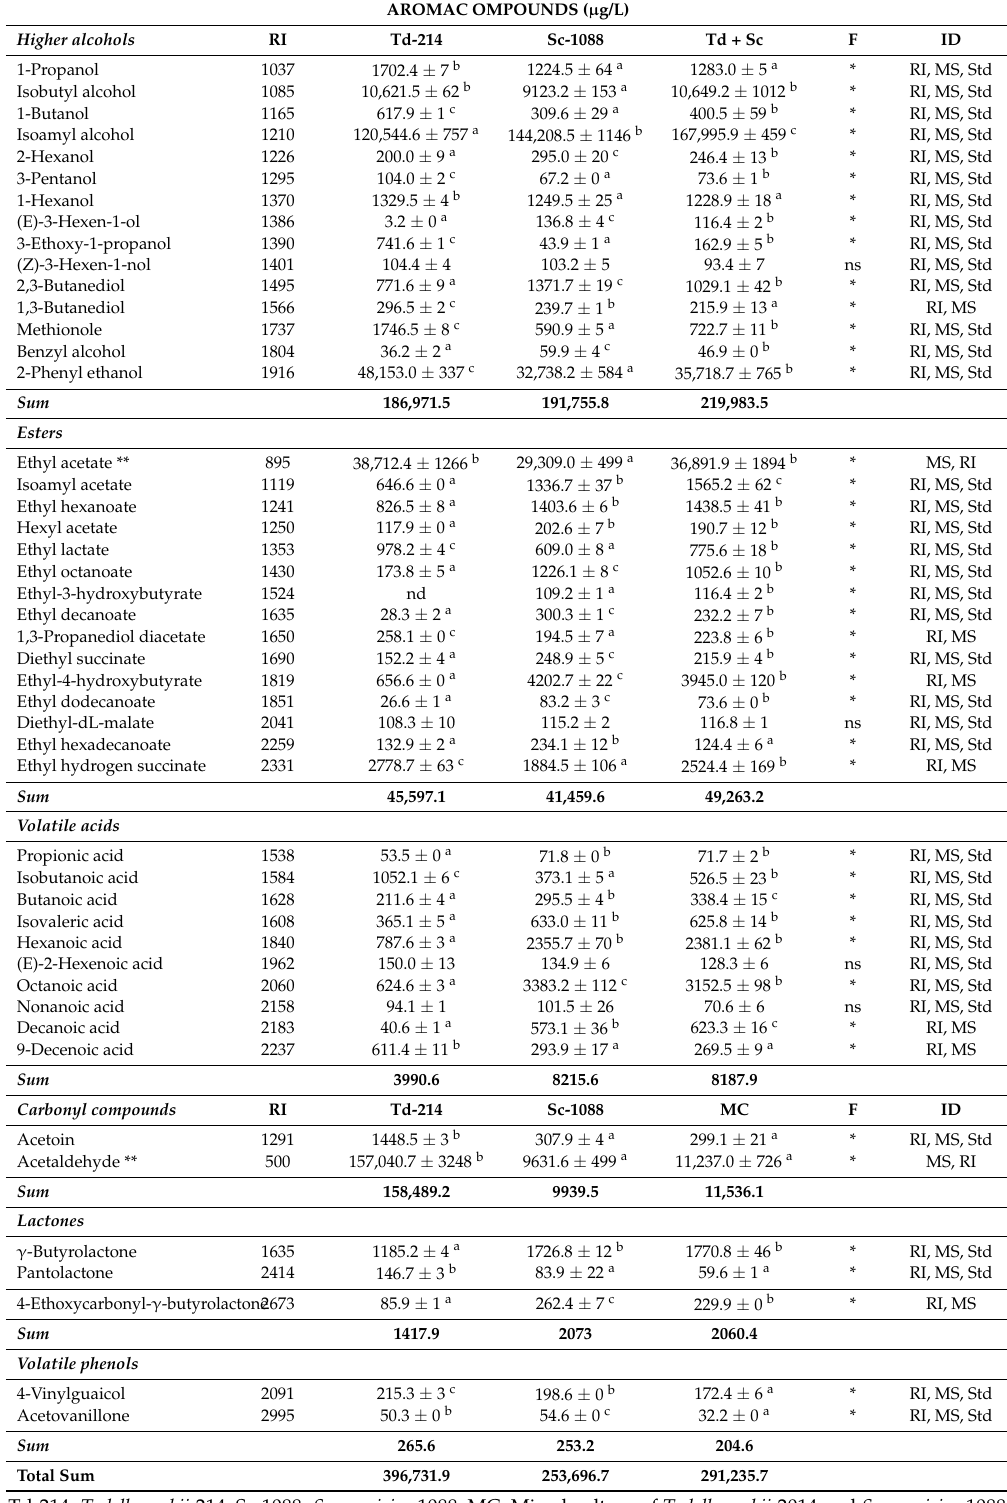
Table 2. Volatile composition of the Narince wines produced in the pure and mixed